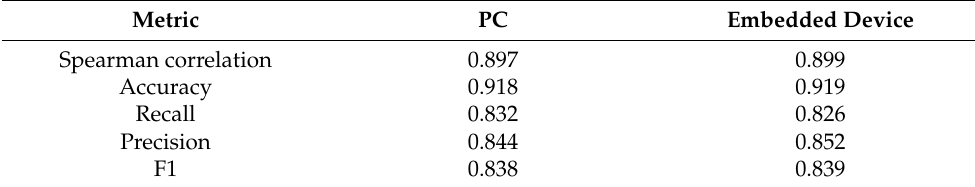
Table 6. Comparison of metrics: PC vs. Embedded